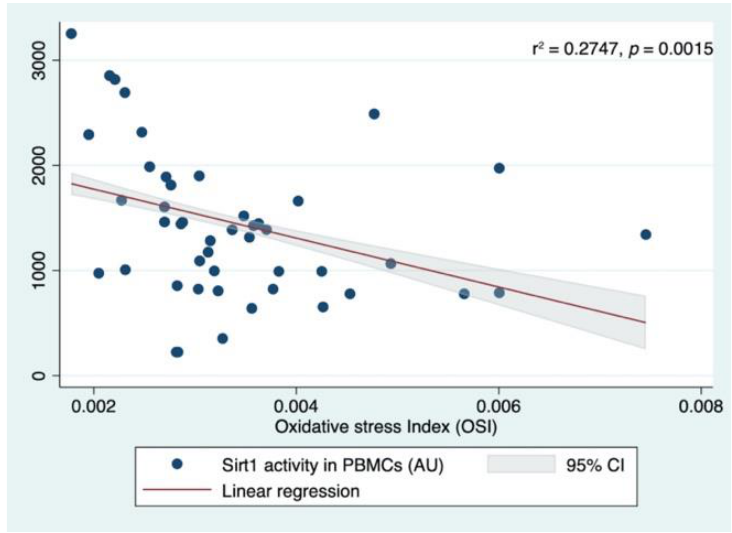
Figure 5. Linear regression analyses with SIRT1 (SIRT1) activity measured in peripheral blood mononuclear cells (PBMCs) and Oxidative Stress Index (OSI) calculated as ratio of TOS on TEAC.